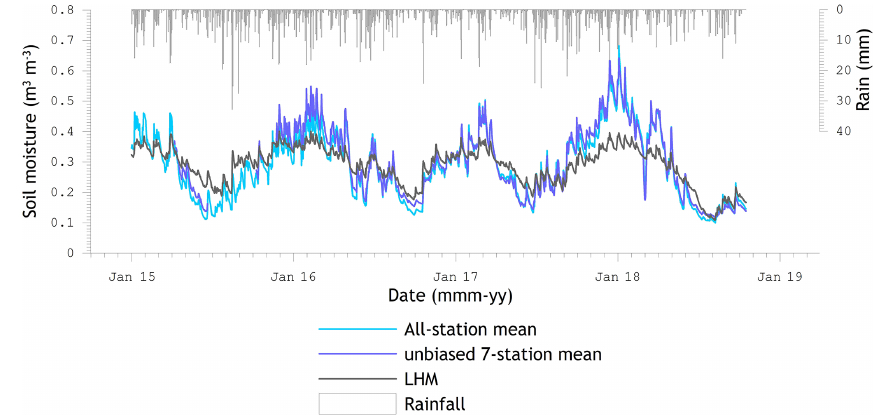
Figure 5. Spatial soil moisture mean for SMAP reference pixels 3306 and 3606 from January 2015 up to October 2018 derived from (i) measurements collected at all available stations, (ii) unbiased measurements from the seven stations operating fairly continuously, and (iii) LHM simulations for the locations where stations are